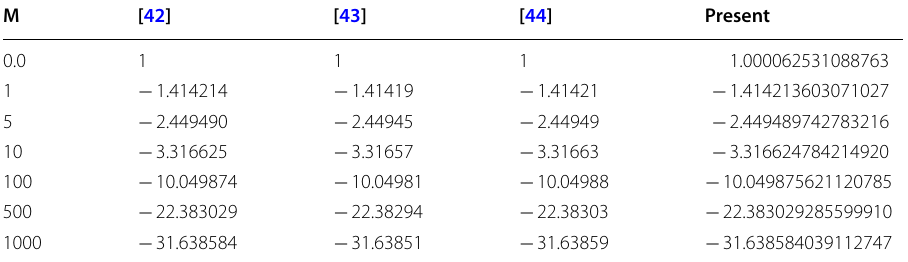
Table 1 Comparison of our results for skin friction with � = ω = Gr = Nr = D ρ = α d = 0 M [42] [43] [44] Present 0.0